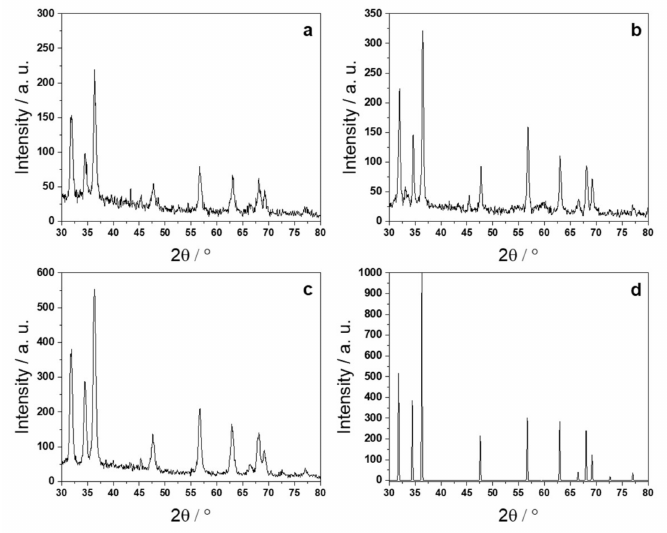
Figure 3. X-ray diffraction patterns of ( a ) CTAB-, ( b ) PDDA-, and ( c ) PSS-stabilized ZnONPs. In ( d ), we report, for comparison, the expected diffraction pattern for pure ZnO